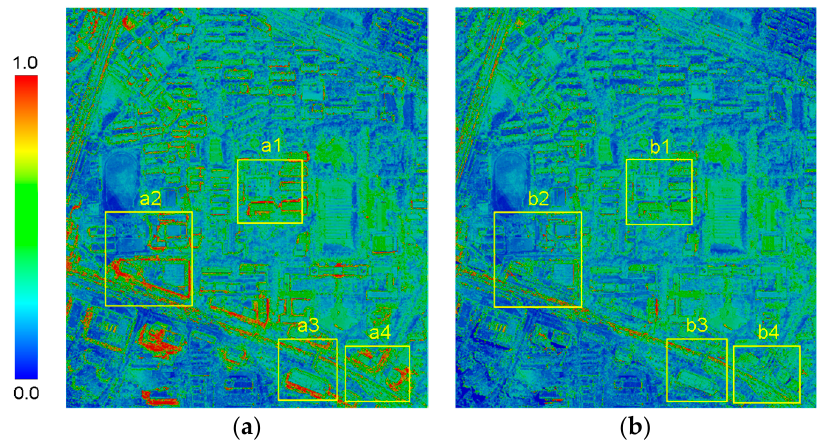
Figure 11. ( a ) Matching cost maps without handling occlusion; and ( b ) matching cost maps with handling occlusion. The matching cost from high to low is rendered from red to blue. Very high cost percentage (larger than 0.95) for the two cost maps is 4.58% and 2.32%, respectively.